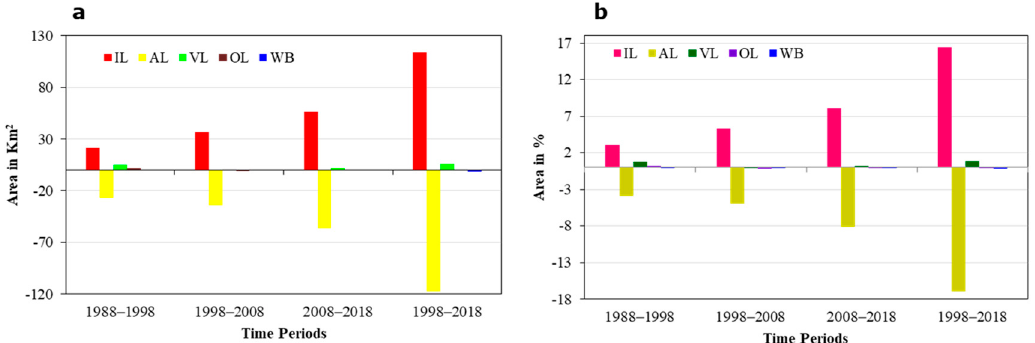
Figure A1. Gains and losses of LULC classes in Kathmandu at decadal intervals from 1988 to 2018, ( a ) area (in Km2); ( b ) percentage area.